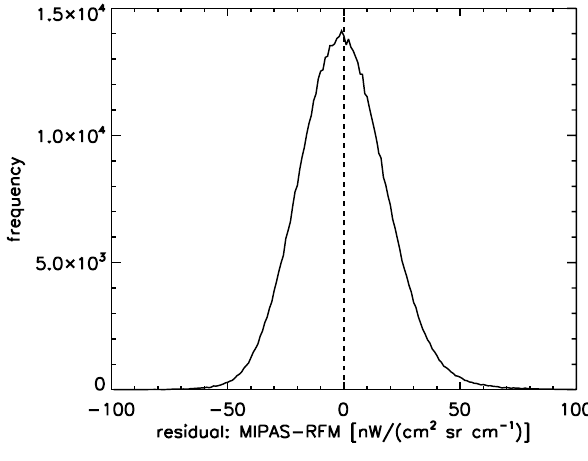
Fig. 5. A histogram of residuals (MIPAS-E measurements-RFM modelled radiances) from 15662 scans from August 2003 at ap- proximately 185hPa. The standard deviation of our residuals is 19nW/(cm 2 srcm − 1 ). Note that the noise equivalent spectral ra- diance in band A of the MIPAS-E is below 25nW/(cm 2 srcm − 1 ) at 800cm − 1 , (Kleinert et al., 2007). The dashed line represents the zero point in the residual.